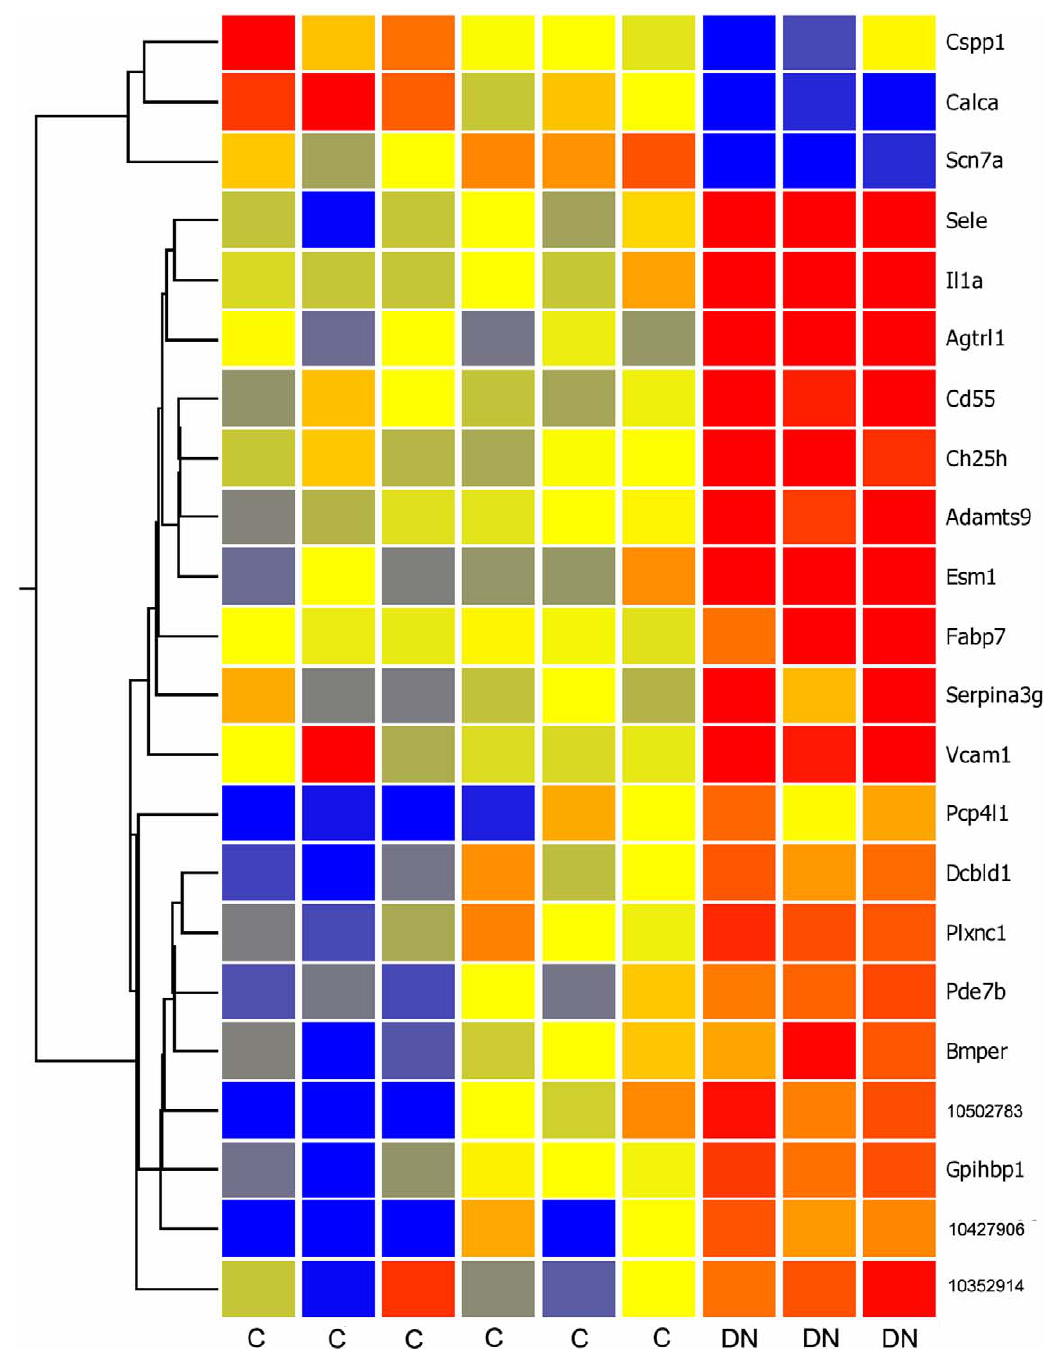
Figure 5. Heat Map of twenty two genes showing the greatest change in expression in glomerulus endothelial cells of diabetic nephropathy db/db mice. Red indicates high level of expression, and blue low expression, with yellow intermediate. C , control samples. DN , diabetic nephropathy db/db mice. Nineteen of the genes were up regulated in db/db mice, and three genes were down regulated.